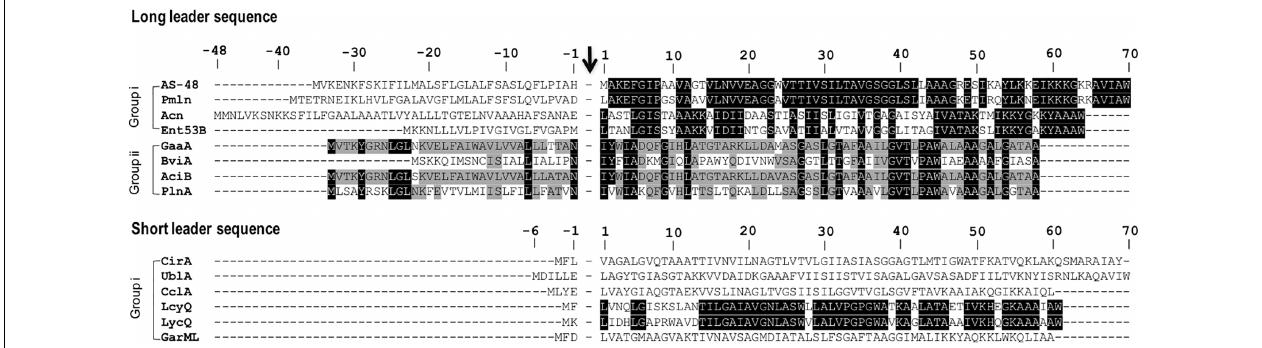
FIGURE 1 | Primary structures of circular bacteriocin precursor peptides. Amino acid positions are numbered and the point of cleavage between the leader peptide and the core peptide is indicated by an arrow. Enterocin AS-48 (AS-48), pumilarin (Pmln), amylocyclicin (Acn), enterocin NKR-5-3B (Ent53B), gassericin A (GaaA), butyrivibriocin AR10 (BviA), acidocin B (AciB), and plantaricyclin A (PlnA) are members of the circular bacteriocins with long leader sequence, whereas circularin A (CirA), uberolysin A (UblA), carnocyclin A (CclA), leucocyclicin Q (LcyQ), lactocyclicin Q (LycQ), and garvicin ML (GarML) belong to circular bacteriocins with short leader sequence. Sub-grouping based on their biochemical features are also indicated as groups i and ii. Circular bacteriocins belonging to group ii showed high sequence homology. Whereas overall sequence comparison of group i bacteriocins showed very limited sequence homology, however, pairwise comparison between, AS-48 and Pmln, Acn and Ent53B, and LcyQ and LycQ showed very high sequence identity. Intensity (black to gray) of the highlighted residue indicates strong conservation of their